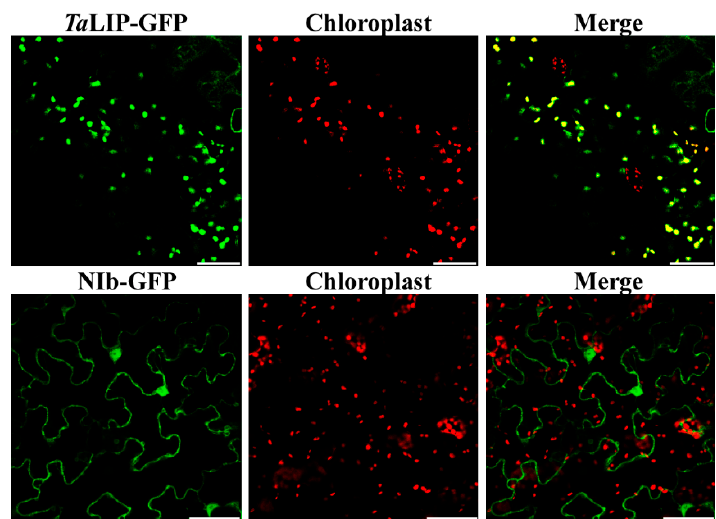
Figure 3. Localization of the Ta LIP and WYMV NIb protein in Nicotiana benthamiana leaves agroinfiltrated with pENTR-NIb-GFP or pENTR- Ta LIP-GFP. The green fluorescent signal of Ta LIP proteins was co-localized with the red auto-fluorescent signal of chloroplasts. Fluorescence photographs were taken at 3 dpi. Scale bar: 50 μ m.